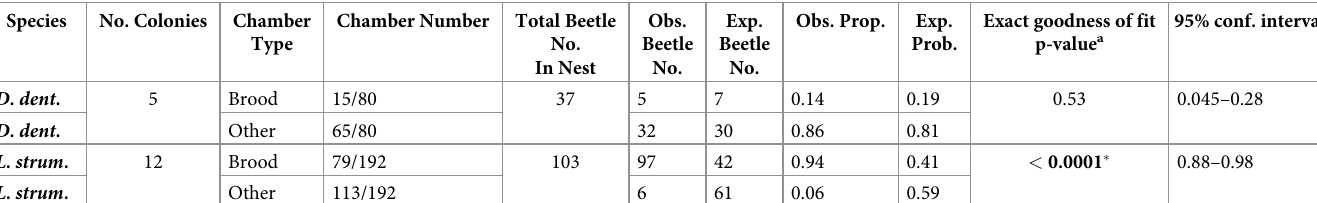
Fig 9. The scavenger Dinarda dentata . Above: Dinarda dentata beetle in the midden of a natural ant nest. Photo courtesy Pavel Kra´sensky´. Below: Dinarda dentata beetle feeding on a dead host ant Formica sanguinea . https://doi.org/10.1371/journal.pone.0210524.g009 Table 1. Results of two exact goodness of fit tests examining differences in D . dentata and L . strumosus preferences for brood chambers within nests.